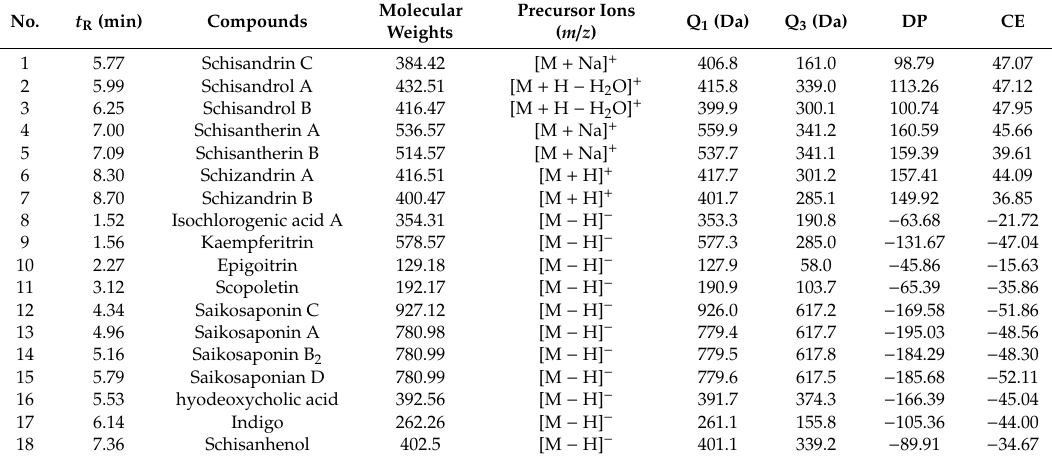
Table1. Valuesdeterminedbythedevelopedultrahighperformanceliquidchromatography–electrospray ionization multiple reaction monitoring tandem mass spectrometry (UHPLC-ESI-MRM-MS / MS)